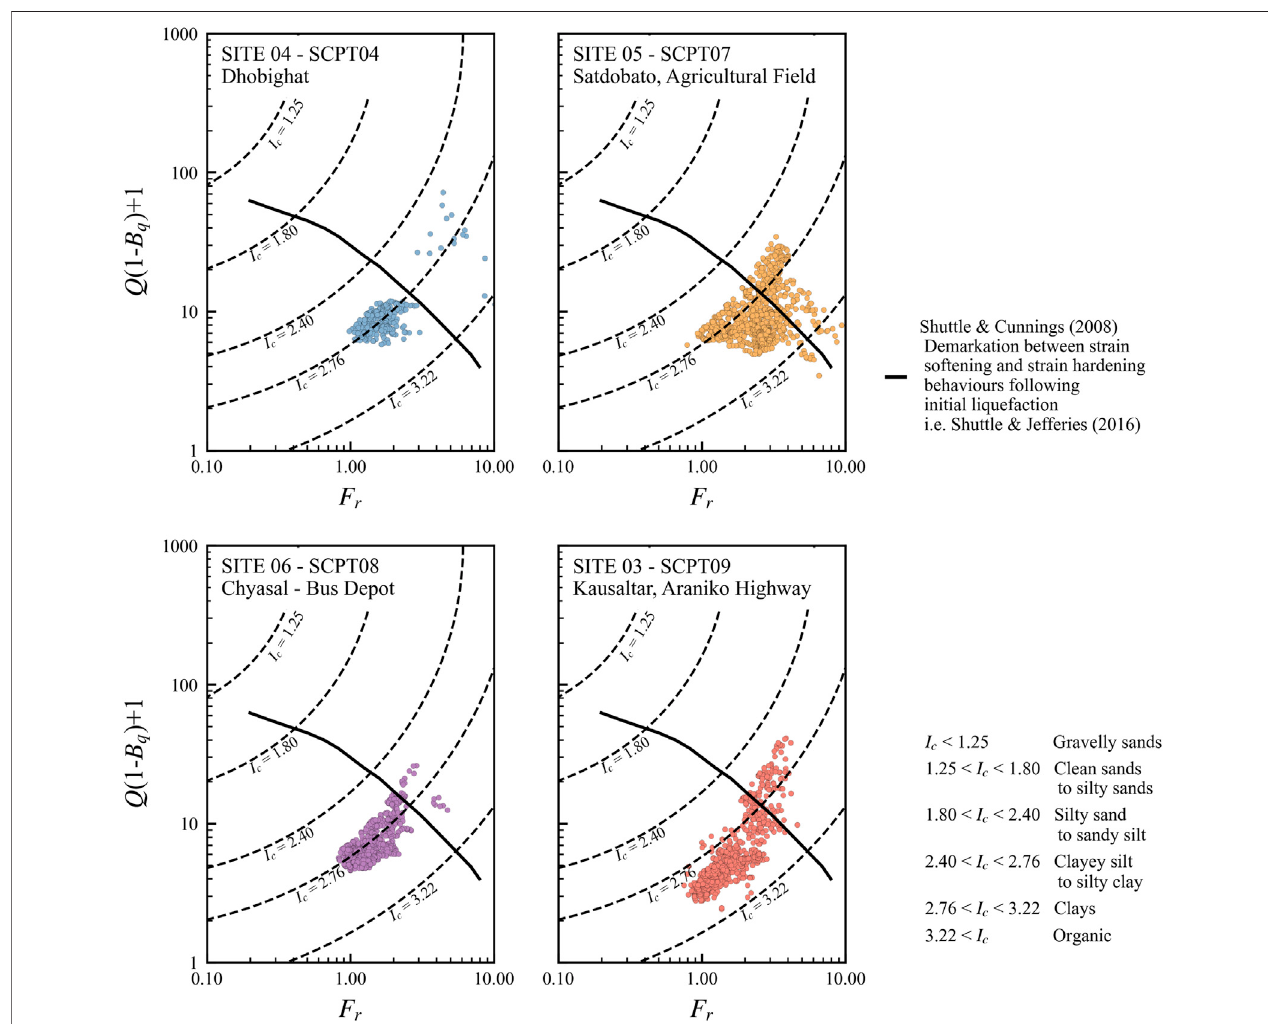
FIGURE 14 | Site results plotted against friction ratio and dimensionless penetration resistance based on vertical stress and pore pressure, Q(1 − Bq) + 1 . Points below the solid line can strain-soften.